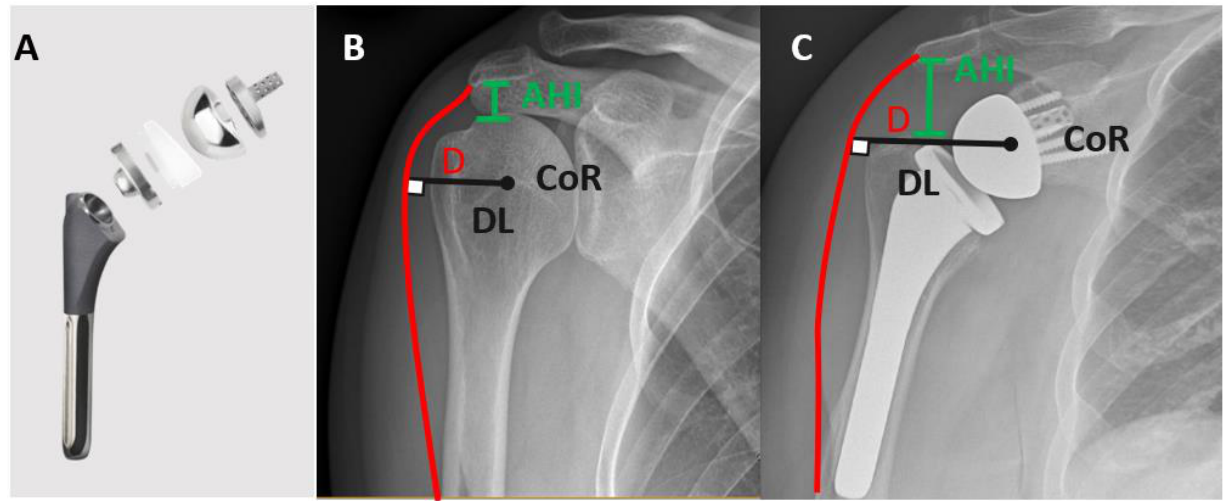
Figure 2. Reverse total shoulder implant ( A ) Biomechanics of a native shoulder ( B ) compared to a reverse total shoulder ( C ); Deltoid lever arm (DL), acromiohumeral interval (AHI) and location of center of rotation (CoR), Deltoid muscle (D).